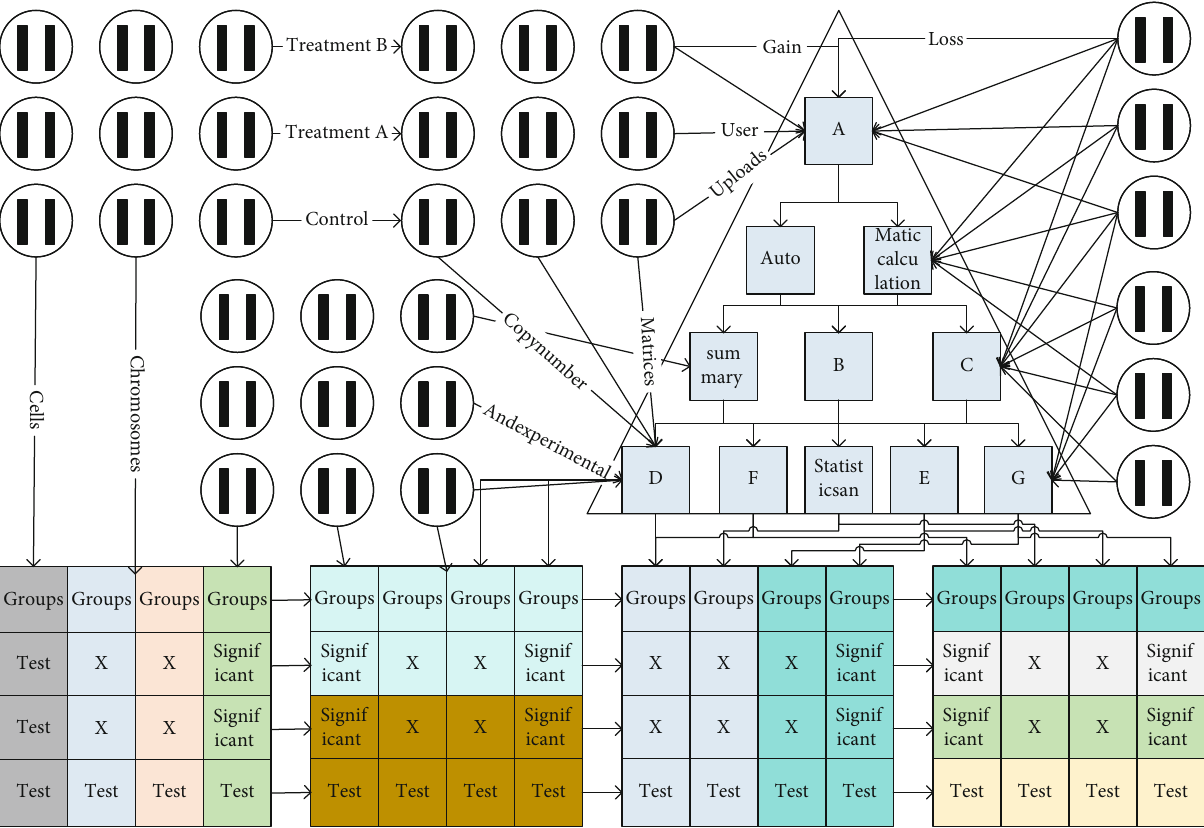
Figure 1: Discriminative target equation face recognition algorithm